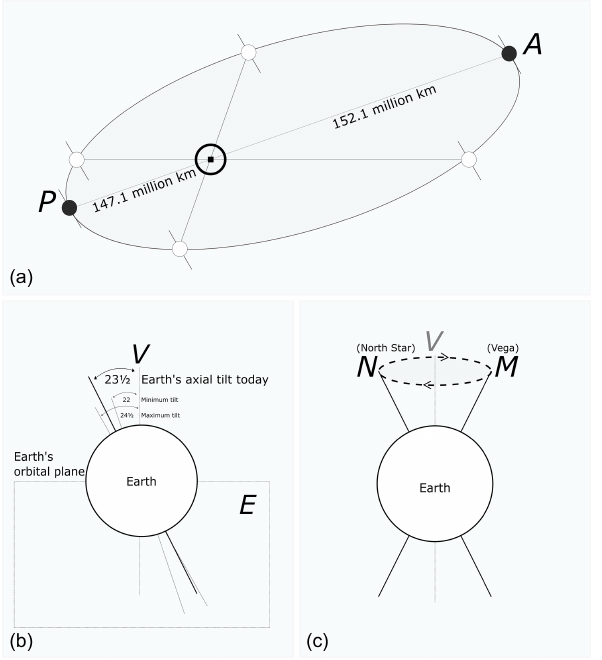
Figure 4. (a) The distances from the Sun at perihelion and aphelion for the Earth today. (b) The maximum, minimum and present tilt angles for the Earth. (c) The wobbling motion of the